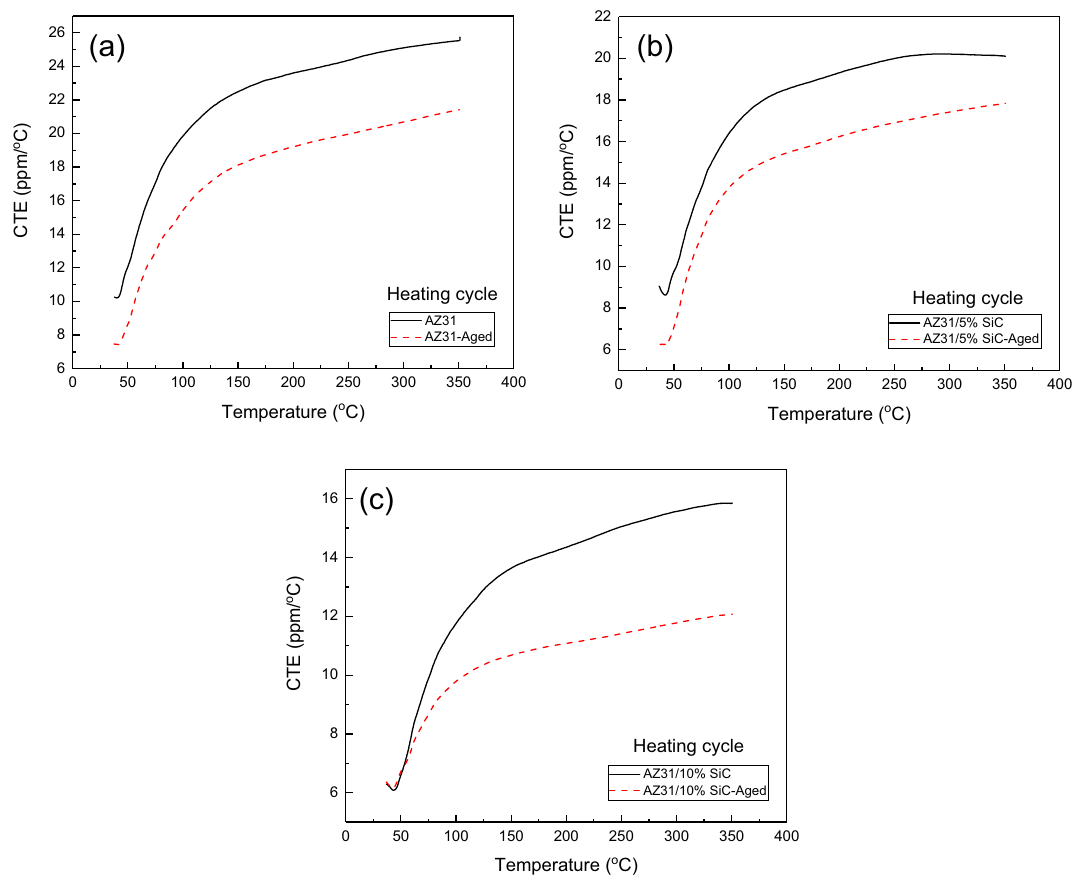
Figure 8. CTE variation verse temperature for as-cast and aged samples: ( a ) unreinforced alloy, ( b ) AZ31/5%SiC, and ( c ) Density. Figure 13a shows the density changes in terms of the number of cycles at 150 °C of unreinforced alloy and AZ31/5%SiC and AZ31/10%SiC composites. According to the figure, it is clear that before performing the thermal cycle, the alloy sample has the highest density, followed by the AZ31/5%SiC sample, and the lowest density is related to AZ31/10%SiC sample. This can be related to the existence of primary cavities in the micro- structure of the composites. Preparation of a composite with a high percentage of reinforcement but without creating a cavity is inevitable. As the number of cycles increases to the first 600, the density changes for compos- ite samples are almost constant. However, the density of unreinforced alloy decreased significantly with increas- ing the number of cycles up to 600. In the open porosity graph in Fig. 13b, the relationship between porosity and the number of cycles at 150 °C for unreinforced alloy and AZ31/5%SiC and AZ31/10%SiC composites can be examined. By increasing the number of cycles up to the first 600, the open porosity changes for composite samples are almost constant. This indicates that at 150 °C, the energy required for the growth of cracks in the microstructure and the energy required for the nucleation of new cracks for the composites is not provided, causing a new porosity. However, the unreinforced alloy sample has a marked increase in porosity by increasing the number of cycles to 600. In fact, for the alloy sample, the energy required for crack nucleation and crack growth is provided. Porosity is an intrinsic property of the composite. However, during thermal cycle testing, cracks can be optimally formed from these porosities 67 . Figure 13c and d show a graph of density changes and porosity percentages in terms of the number of cycles at 350 °C of unreinforced alloy and AZ31/5%SiC and AZ31/10%SiC composites. The conditions for as-cast samples under thermal cycles of high temperature (350 °C) are similar to those of low temperature (150 °C). However, the AZ31/5%SiC sample also showed an increase in open porosity at 350 °C from 300 to 600 cycles, which is the reason for the increase and growth of cracks. No noticeable change is observed in most thermal cycles up to 900 cycles.